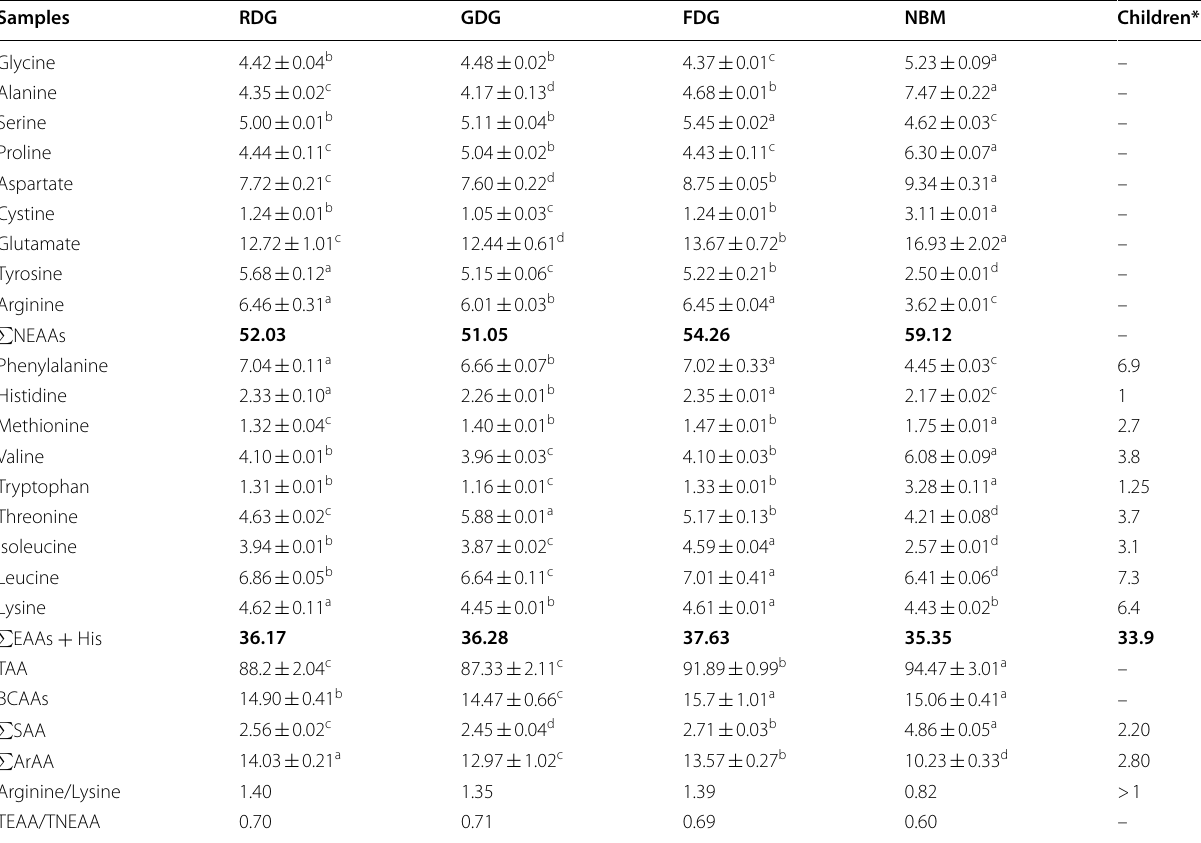
Table 2 Amino acid profiles (g/100 g protein) of formulated complementary foods from maize, defatted groundnut and ginger flour